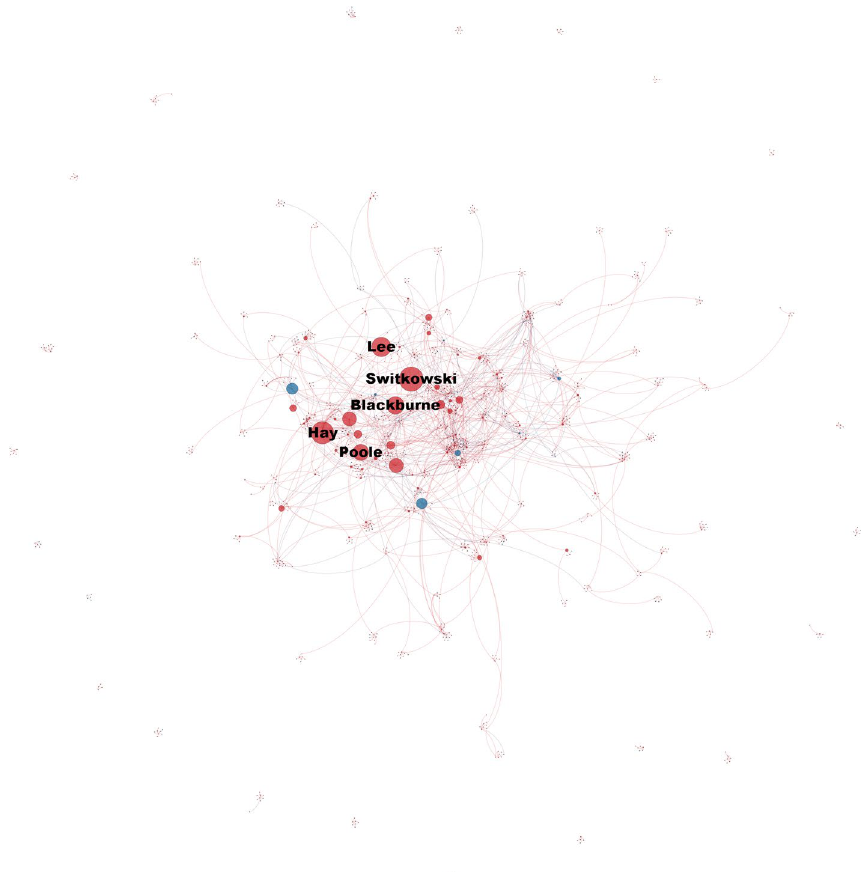
Fig. 5 Network Graph: Betweenness Centrality